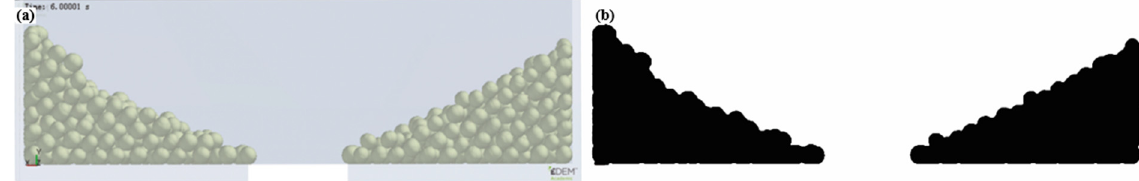
Figure 20. ( a ) EDEM simulation snapshot of the piling angles and ( b ) its binarization image using the 13-ball model.